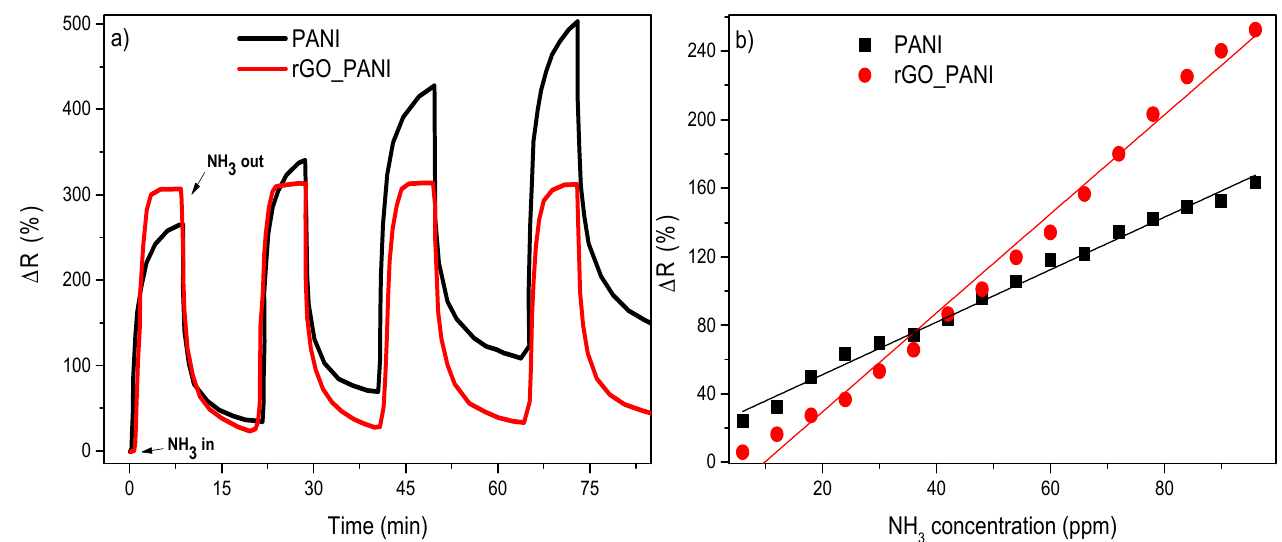
Figure 7. ( a ) Sensitivity versus time (at 600 ppm of NH 3 ) and ( b ) calibration curves.